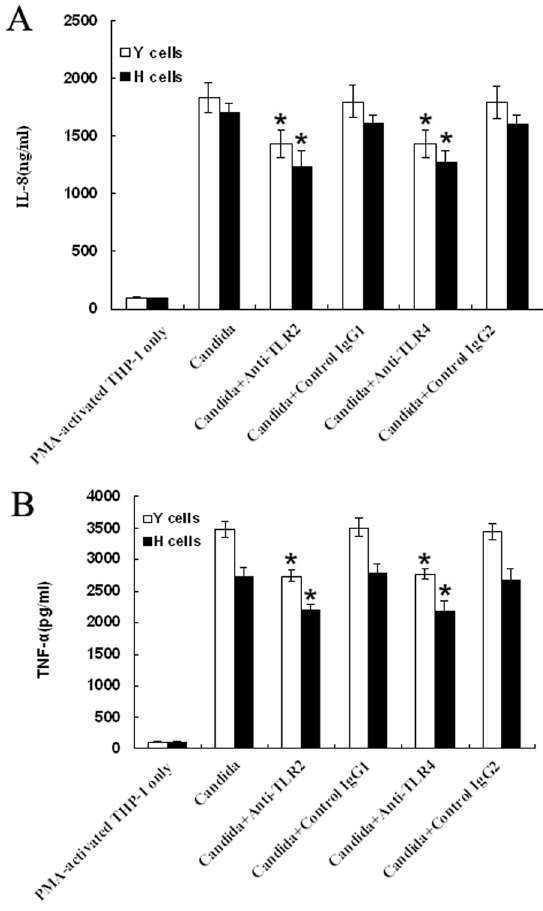
Figure 6. Blocking TLR2 or TLR4 inhibits C.albicans -induced IL- 8 and TNF- a secretion in PMA-activated THP-1 cells. PMA- activated THP-1 cells were incubated with anti-TLR2 mAb or mouse isotype IgG1 (as a control), anti-TLR4 mAb or mouse isotype IgG2 (as a control), respectively. After 1 h of incubation, cells were stimulated with HK Y or H cells of C. albicans at a Candida/THP-1 ratio of 2:1 for 24 h. Supernatants were harvested and subjected to ELISA for IL-8 (A) and TNF- a (B). The data are expressed as mean 6 SD of four independent experiments. *P , 0.05 as compared to C. albicans -stimulated group. Similar results were observed in four independent